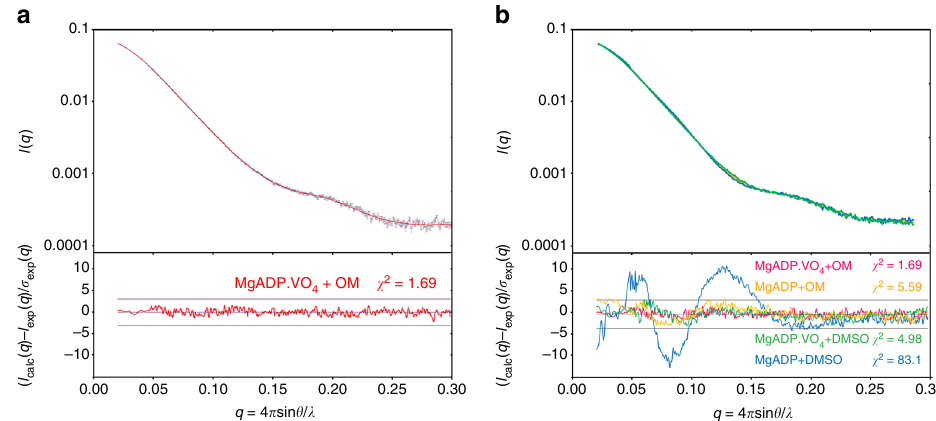
Fig. 4 SAXS data show that, in solution, OM populates a myosin conformational state similar to PPS. a ( Upper panel ) Experimental scattering intensities of the MgADP.VO 4 +OM condition in black (with associated error bars ) superimposed on the calculated scattering patterns of the OM-S1-PPS structure is shown as a continuous red line . ( Lower panel ) Reduced residuals of the least-squares fi ts shown on a linear scale ( ± 3 σ indicated with horizontal lines ). The quality of the fi t ( χ 2 = 1.69) reveals that the crystal structure corresponds to the conformation adopted in solution. b ( Upper panel ) Experimental scattering intensities of the MgADP+OM ( yellow ), MgADP.VO 4 +DMSO ( green ), and MgADP+DMSO ( blue ). ( Lower panel ) The χ 2 -value re fl ects the discrepancy between the different experimental curves and the theoretical scattering of the OM-S1-PPS structure. Note how similar are the curves with MgADP.VO 4 or bound to OM, and how they differ from that of MgADP in the absence of OM ( blue )